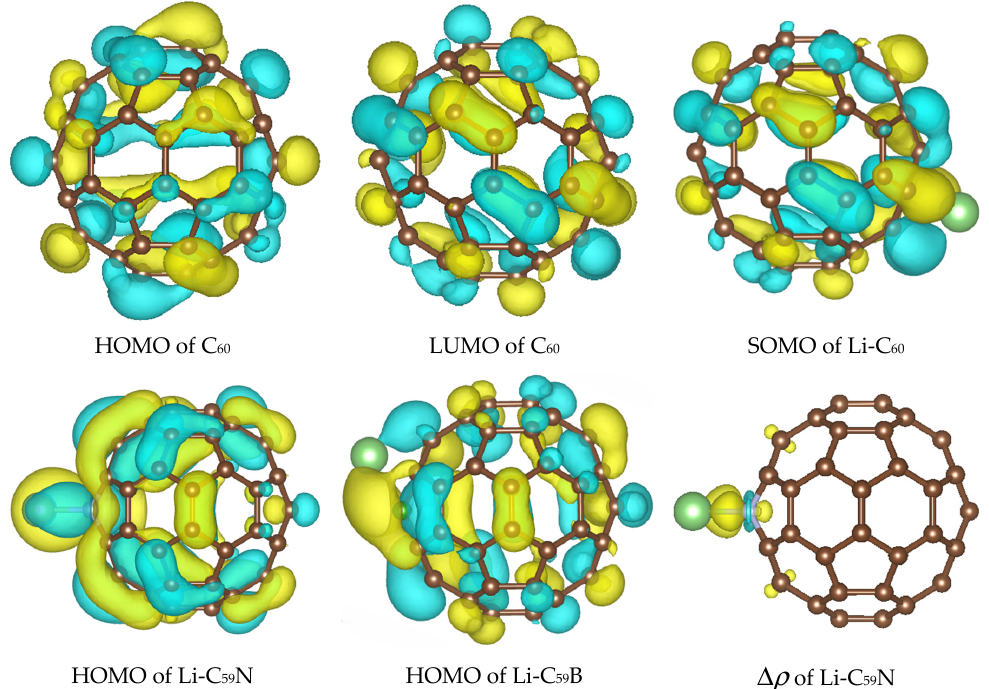
Figure 2. Highest occupied molecule orbital (HOMO), lowest unoccupied molecular orbital (LUMO) of C 60 and the orbital occupied by the Li valence electron in Li–C 60 , Li–C 59 N, and Li–C 59 B, as well as charge density difference map Δ ρ showing bond formation between Li and N dopant. Results of B3LYP calculations are shown, those with PBE are visually similar. Isosurface values are 0.02 e 1/2 /Å 3 for orbitals and 0.005 e 1/2 /Å 3 for the charge density difference map. The atomic color scheme is C—brown, N—grey, B—green, Li—light green.